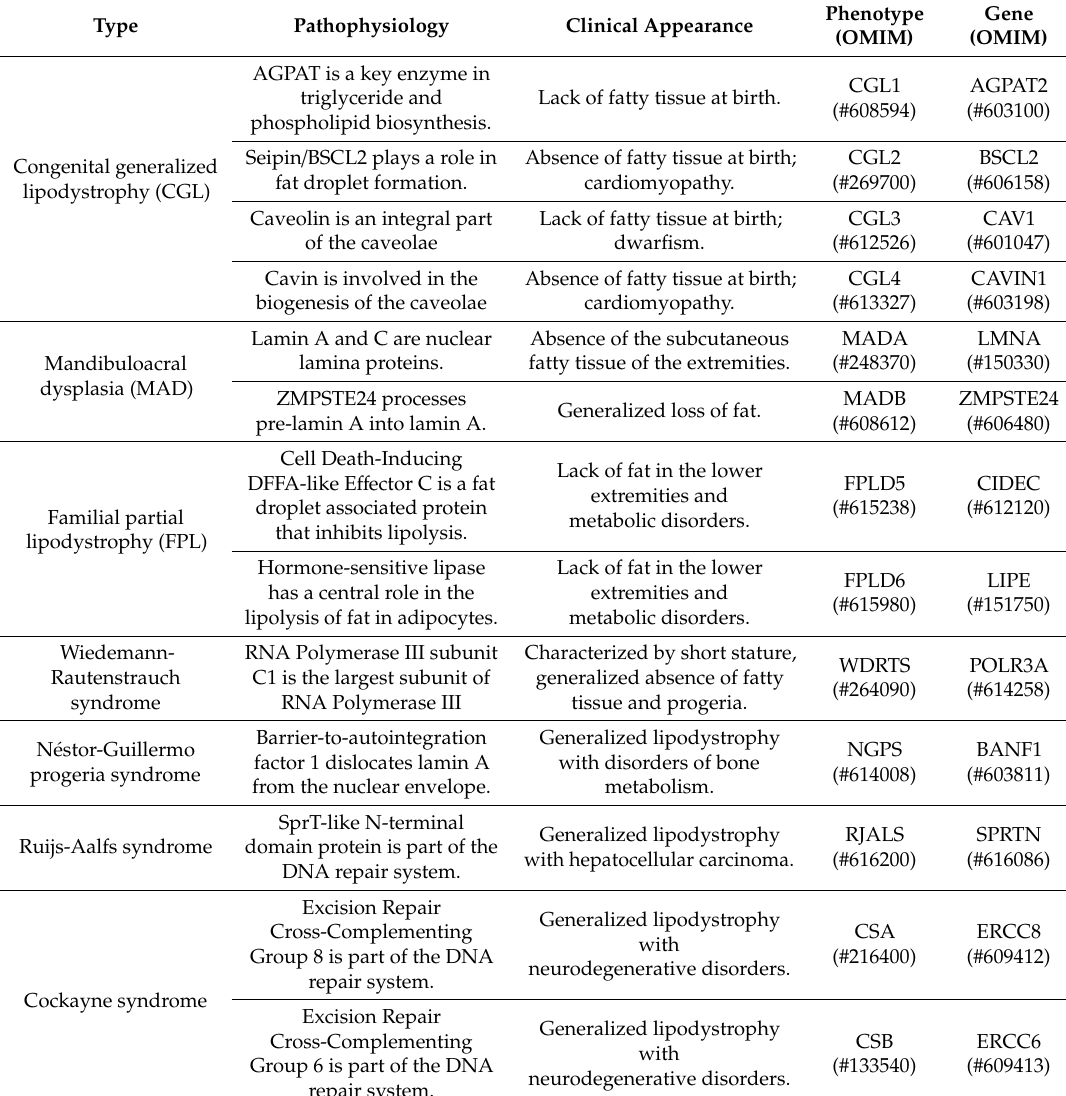
Table 1. Classification of autosomal recessive forms of